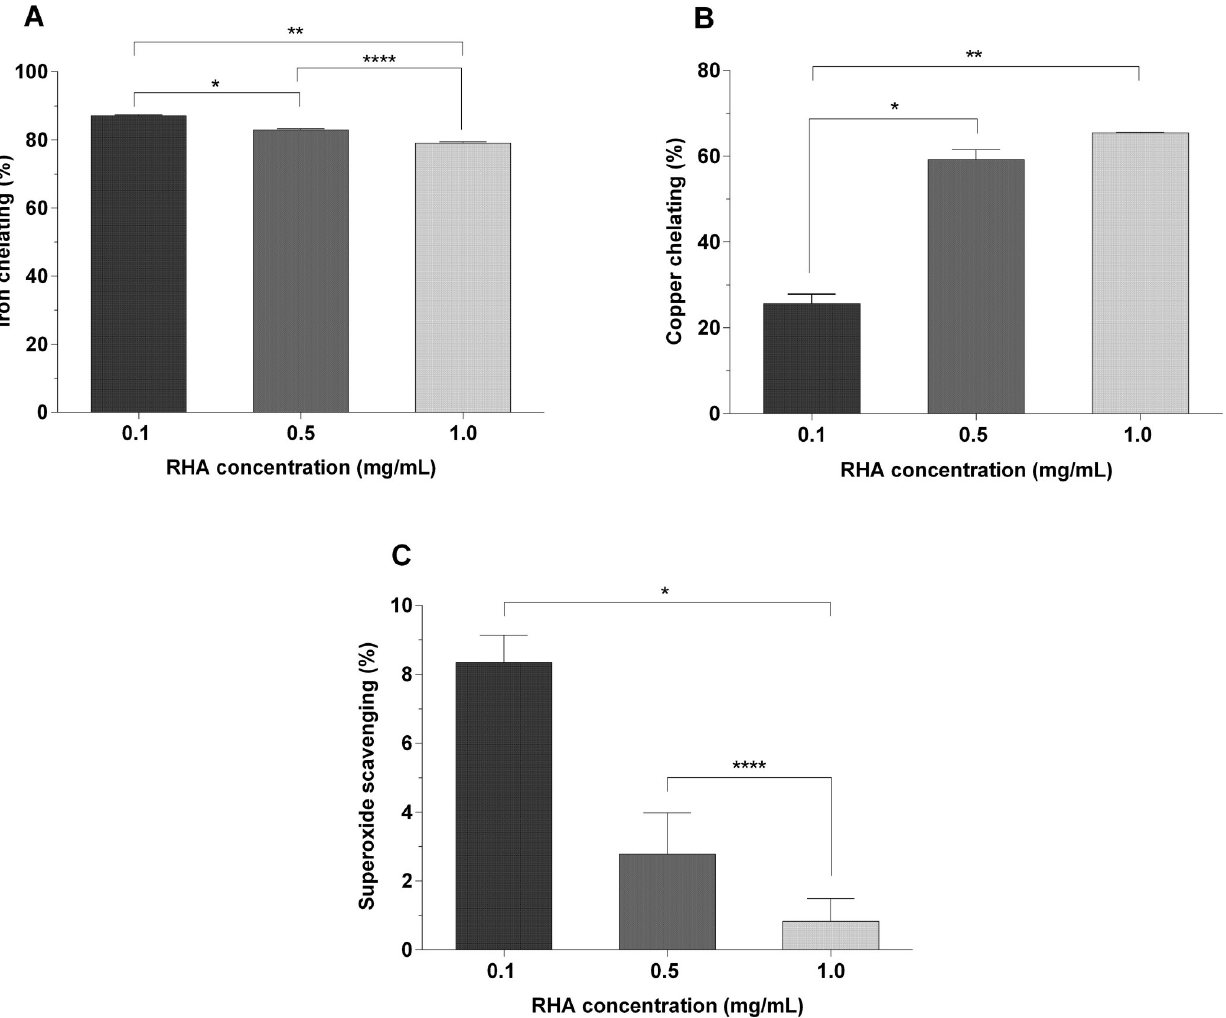
Fig 3. In vitro determination of the antioxidant activity of RHA. Concentration of extract (RHA): 0.1 to 1.0 mg/mL. On the x-axis, there are the RHA concentrations (in mg/mL), and on the y-axis, the percentage of antioxidant activity. Results expressed as mean ± standard error of the mean (n = 3). A: Iron chelating assay; B: Copper chelating assay; C: Superoxide scavenging assay. � : Statistical significance.